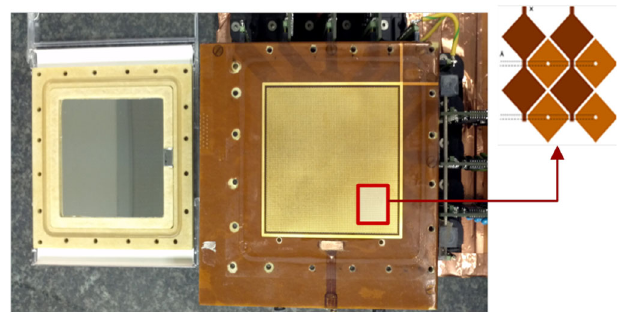
FIG. 14. Multistrip IC-2D chamber prototype components: (left) the anode aluminized Mylar window glued on the glass fiber epoxy Permaglas frame; (center) the segmented cathode made by a layer of kapton and copper pads connected by strips along x and y (upper-right